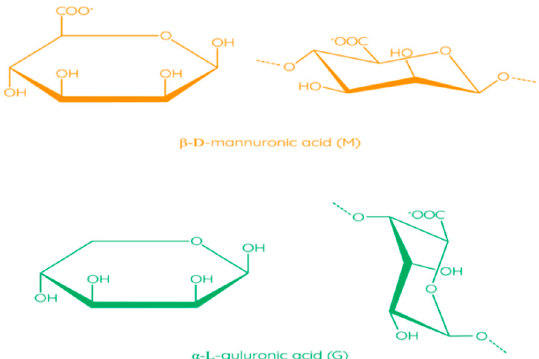
Figure 6. Structural formulas of monomers in alginate [97]. Reproduced from Parreidt, T.S. et al., Foods; published by MDPI, Basel, Switzerland, 2018.